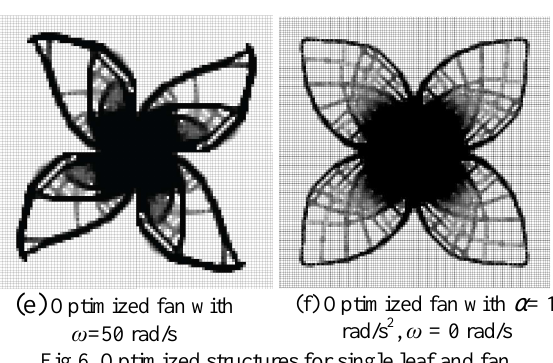
Fig.6. Optimized structures for single leaf and